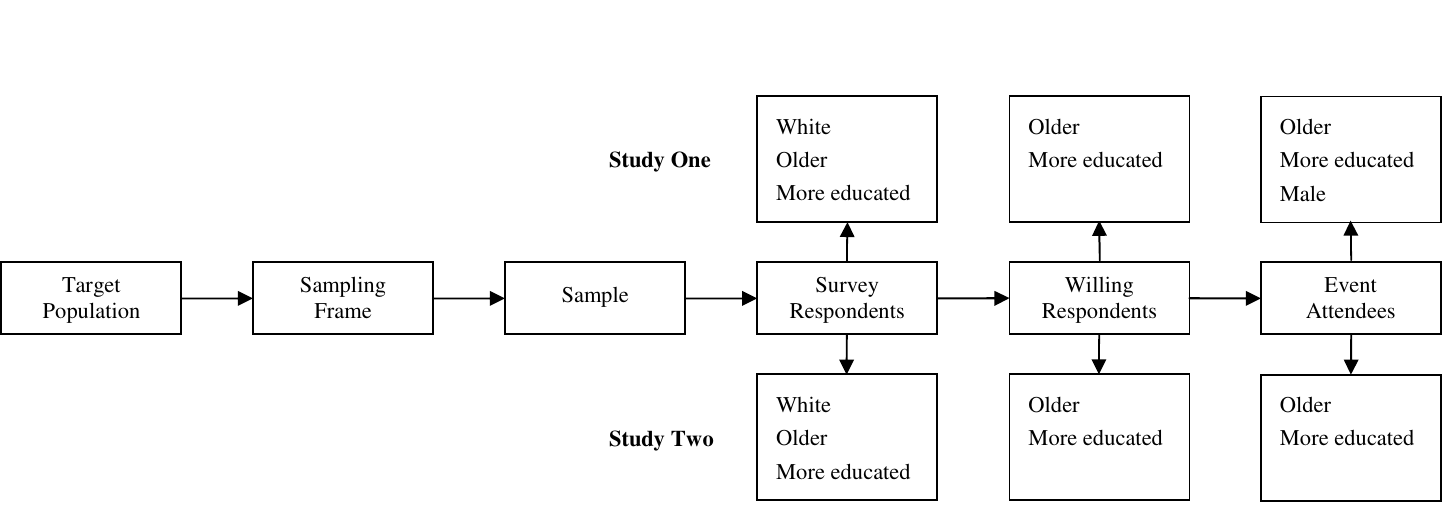
Figure 2. Participant representativeness via Census